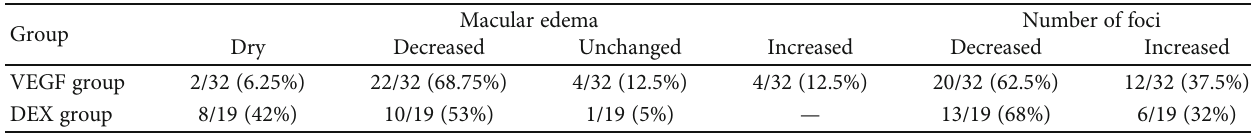
Figure 3: Boxplot graph representing changes in central retinal thickness (CRT), number of hyperre fl ective foci (HF), and number of hard exudates (HE) after anti-VEGF therapy (VEGF group) or dexamethasone implantation (DEX group) in patients with diabetic macular edema (DME). Figure shows the di ff erence in change in (a) CRT in μ m (b) number of HF, and (c) number of HE for the VEGF and DEX group at baseline versus 15 or 30 days after the injection. Table 3: Assessment percentage of eyes with a change in macular edema and change in the number of hyperre fl ective foci at the end of the treatment